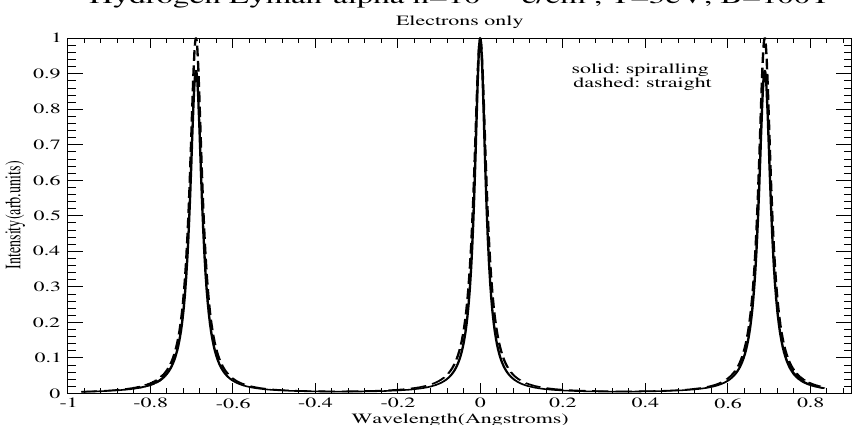
solid: spiralling dashed: straight